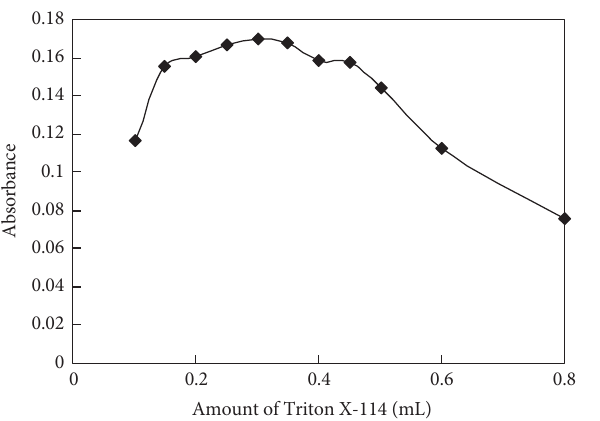
F 5: Effect of the amount of Triton X-114 on the absorbance of Co(II). Conditions: 2.0